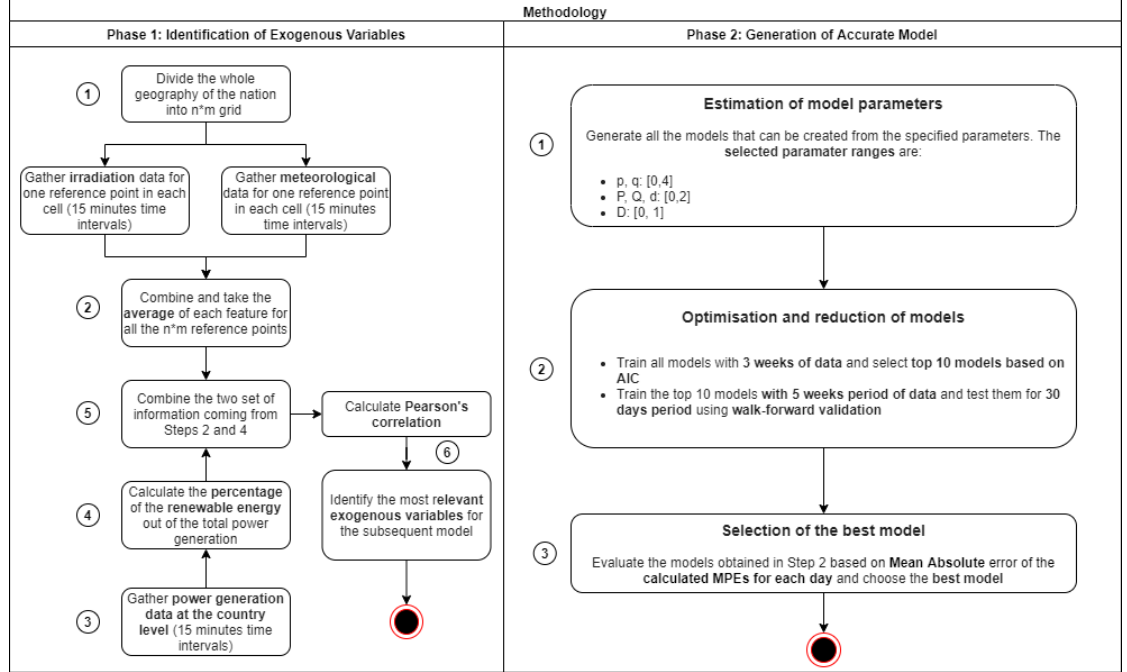
Figure 1. The two phases of the proposed methodology with their corresponding